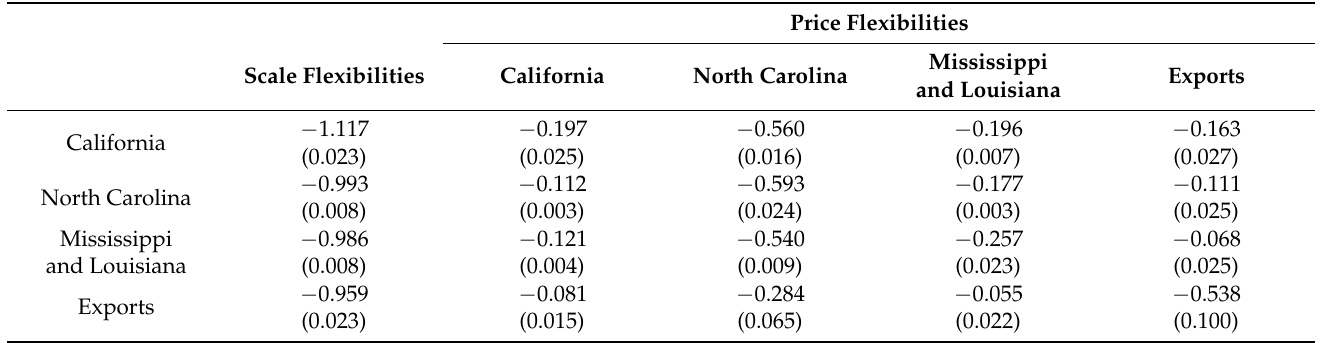
Table 4. Elasticities and price flexibilities for the synthetic inverse demand